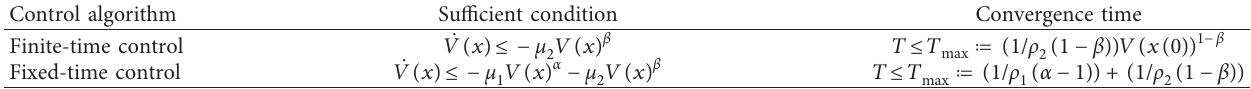
Table 1: The sufficient condition and convergence time for finite-time control and fixed-time control. Control